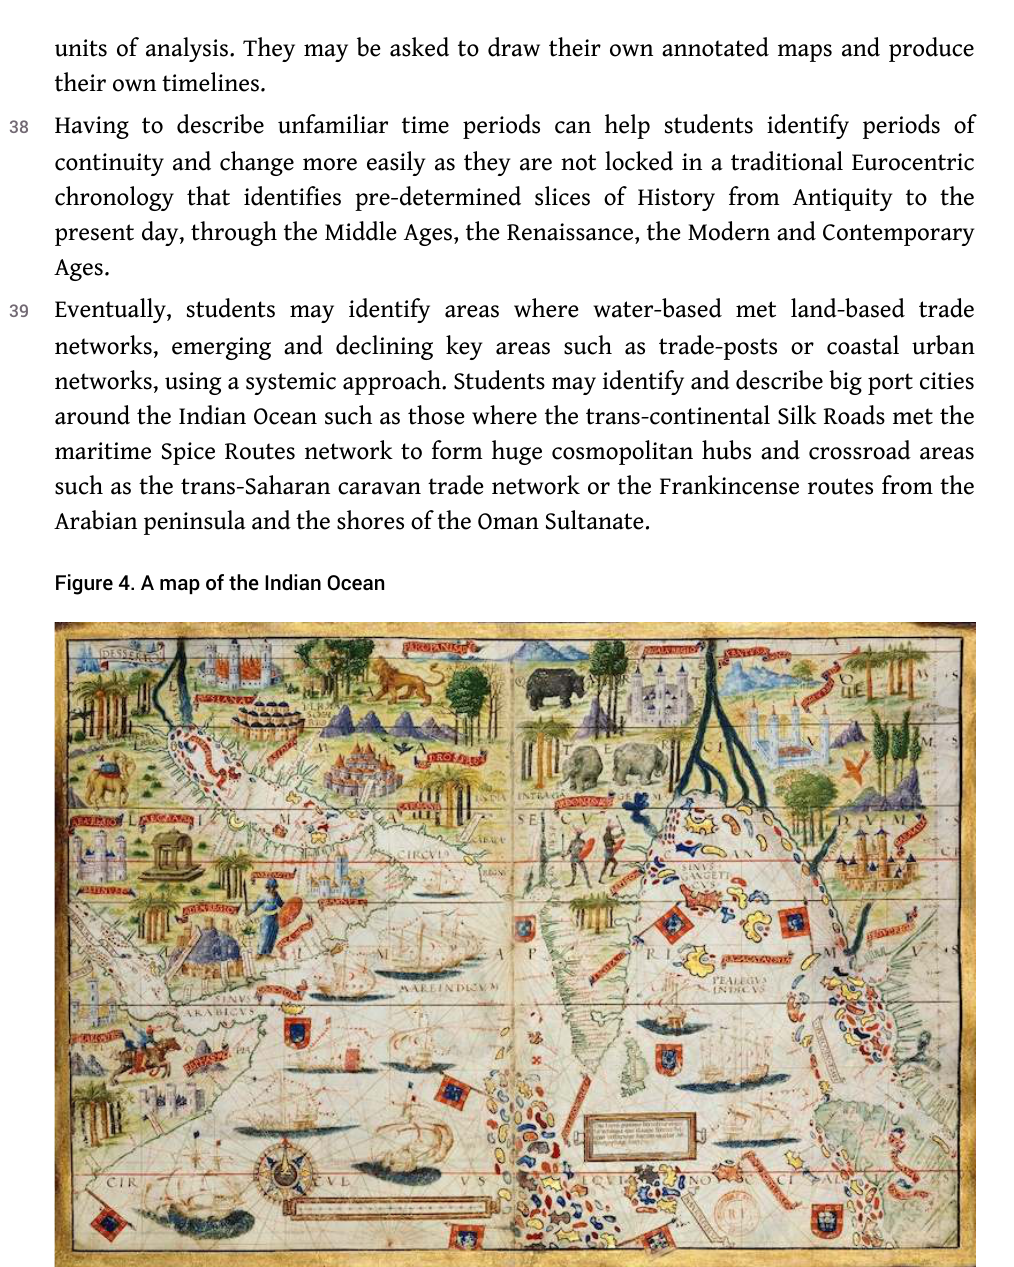
Dated c. 1519 from the Miller Atlas in La fabrique de l’Océan indien , Emmanuelle Vagnon and Eric Vallet eds., Paris: Editions de la Sorbonne, 2017, p. 113. Source: